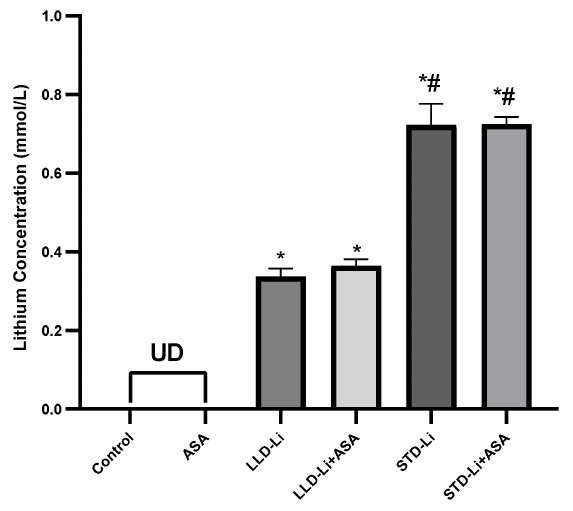
Figure 1. Li blood levels in aspirin + Li-treated rats. Rats were fed regular food (control) or Li- containing food [0.1% (LLD-Li), 0.2% (STD-Li)] for 42 days. Low-dose ASA (1 mg/kg, ip) was administered alone or together with Li. Blood was collected on days 0 and 42 of treatment, plasma separated, and Li levels determined as described in Materials and Methods. Li levels were unde- tectable in all groups on Day 0 and thus are not presented in the Figure. Results are the means ± SEM of a single representative experiment out of two demonstrating a similar pattern with 9–12 rats per group in the depicted experiment. * p < 0.0001 vs. Control, # p < 0.0001 vs. LLD Li. Two-way